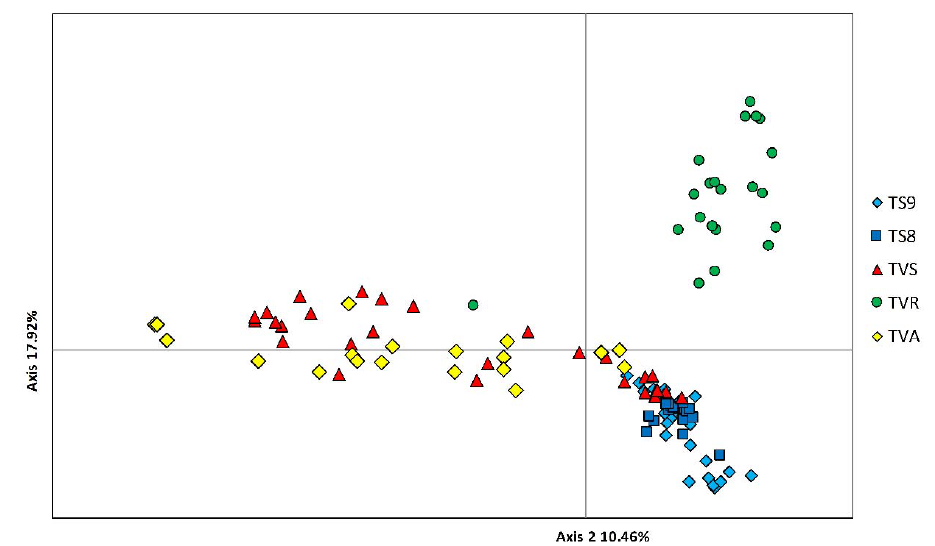
Figure 3. Principal coordinates analysis (PCoA) based on all single-nucleotide polymorphisms (SNPs).